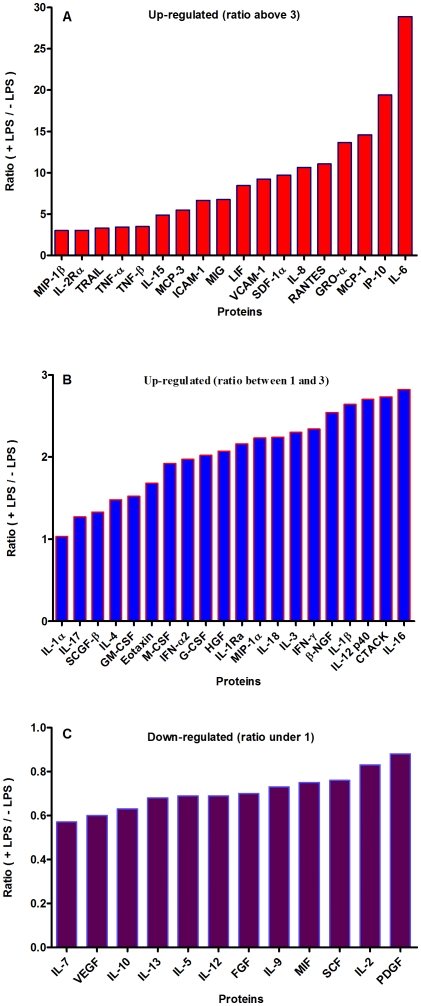
A comparison analysis of 50 cytokines/chemokines between adipocytes and adipocytes treated with LPS.Figures 5 A and B show up-regulation above ratio 3 (panel A) and from ratio 1 to 3 (panel B) and down-regulation (panel C, ratio under 1), respectively, of cytokine and chemokine proteins before and after lipopolysaccharide (LPS) stimulation (200 ng/ml with a final concentration of 1 µg for 24 h), using a multiplex ELISA cytokine/chemokine protein BeadArray. Protein expression was expressed as the ratio of LPS-treated/untreated and is shown on the y-axis. Preadipocytes are shown in red bars and adipocytes in blue bars.